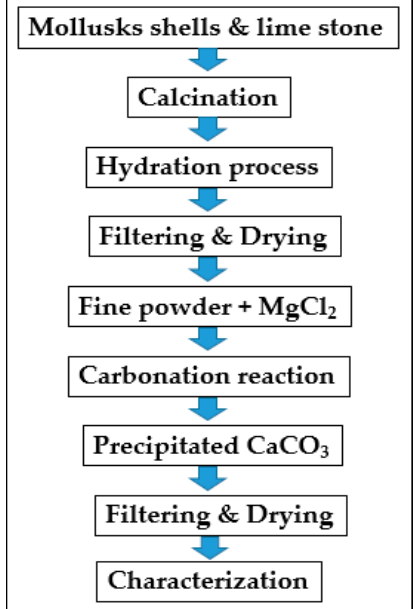
Figure 4. Aragonite needles synthesis from mollusk shell and limestone by carbonation process.